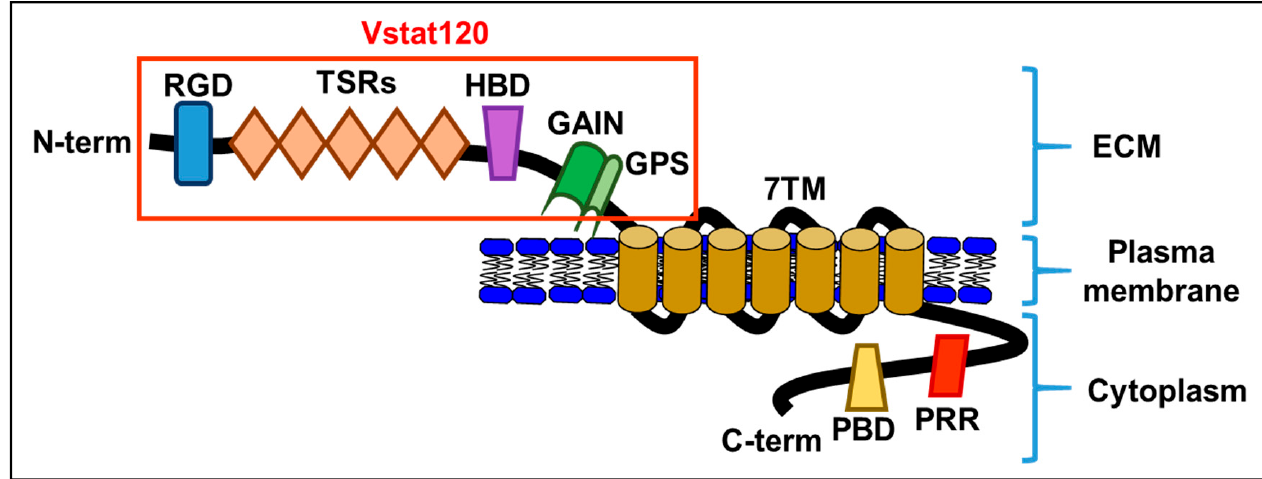
Figure 1. A schematic diagram of the brain-specific angiogenesis inhibitor (BAI) domains: RGD, integrin-binding Arg-Gly-Asp motif; TSRs, thrombospondin type 1 repeats; HBD, putative hormone-binding domain; GAIN, GPCR autoproteolysis-inducing domain; GPS, GPCR autoproteolysis site; 7TM, seven-transmembrane domain; PRR, proline-rich region; PBD, PDZ-binding domain. Vstat120, secreted extracellular BAI1.